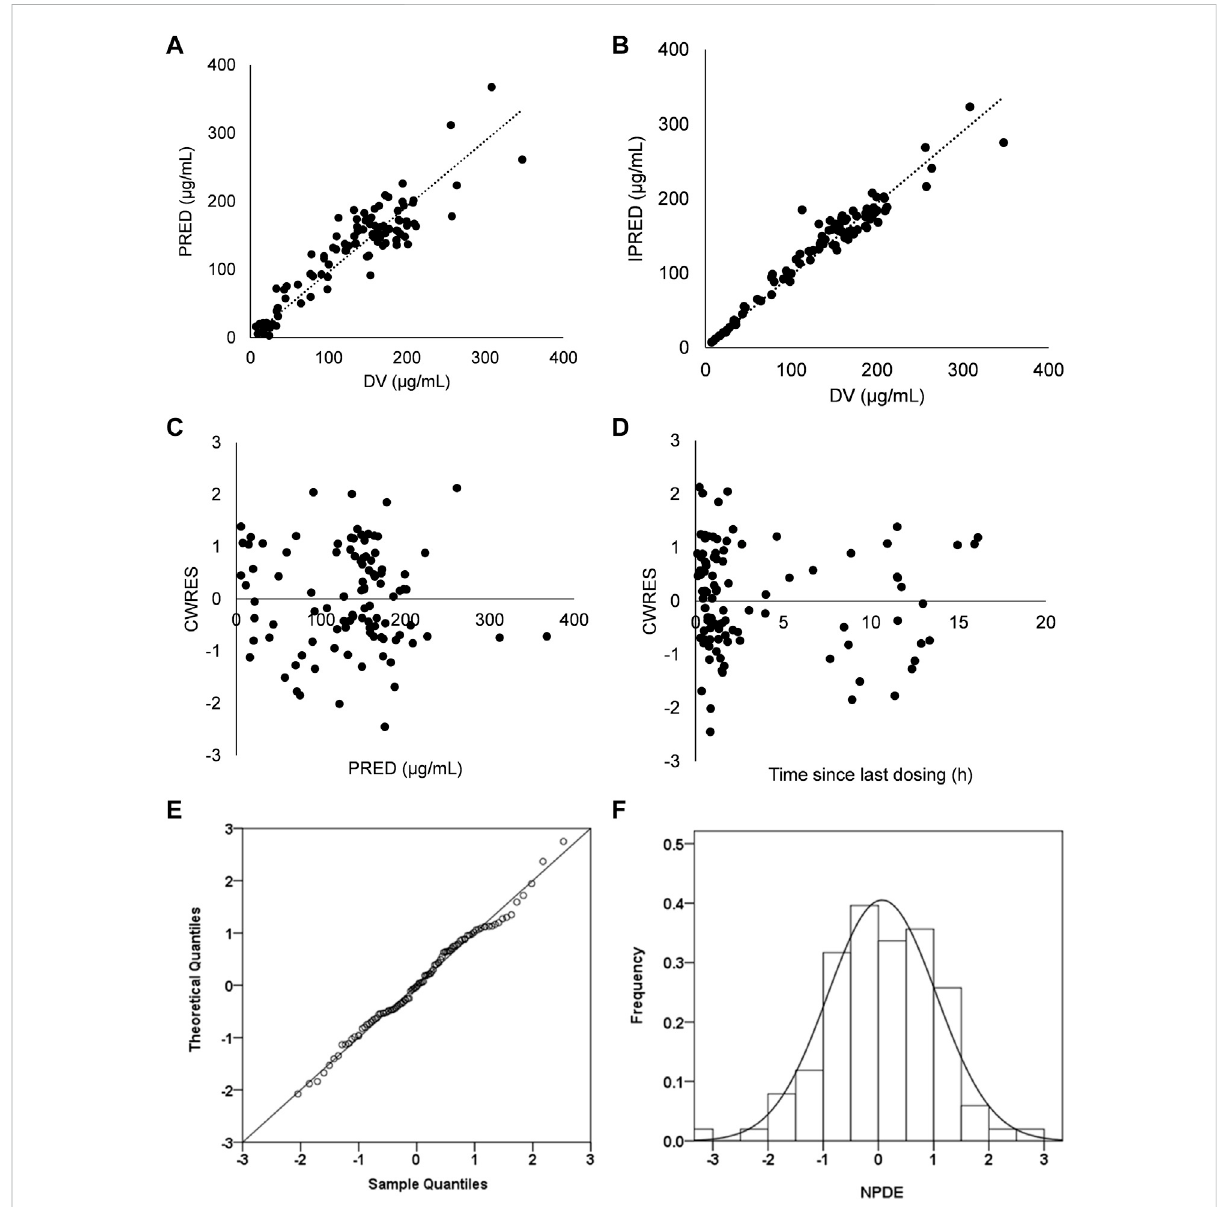
Model evaluation for cefotaxime (A) Population predicted concentrations (PRED) versus observed concentrations (DV). (B) Individual predicted concentrations(IPRED)versusDV (C) Conditionalweightedresiduals(CWRES)versusPRED. (D) CWRESversustime. (E) QQ-plotofthedistributionof the Normalized Prediction Distribution Errors (NPDE) versus the theoretical N (0,1) distribution. (F) Histogram of the distribution of the